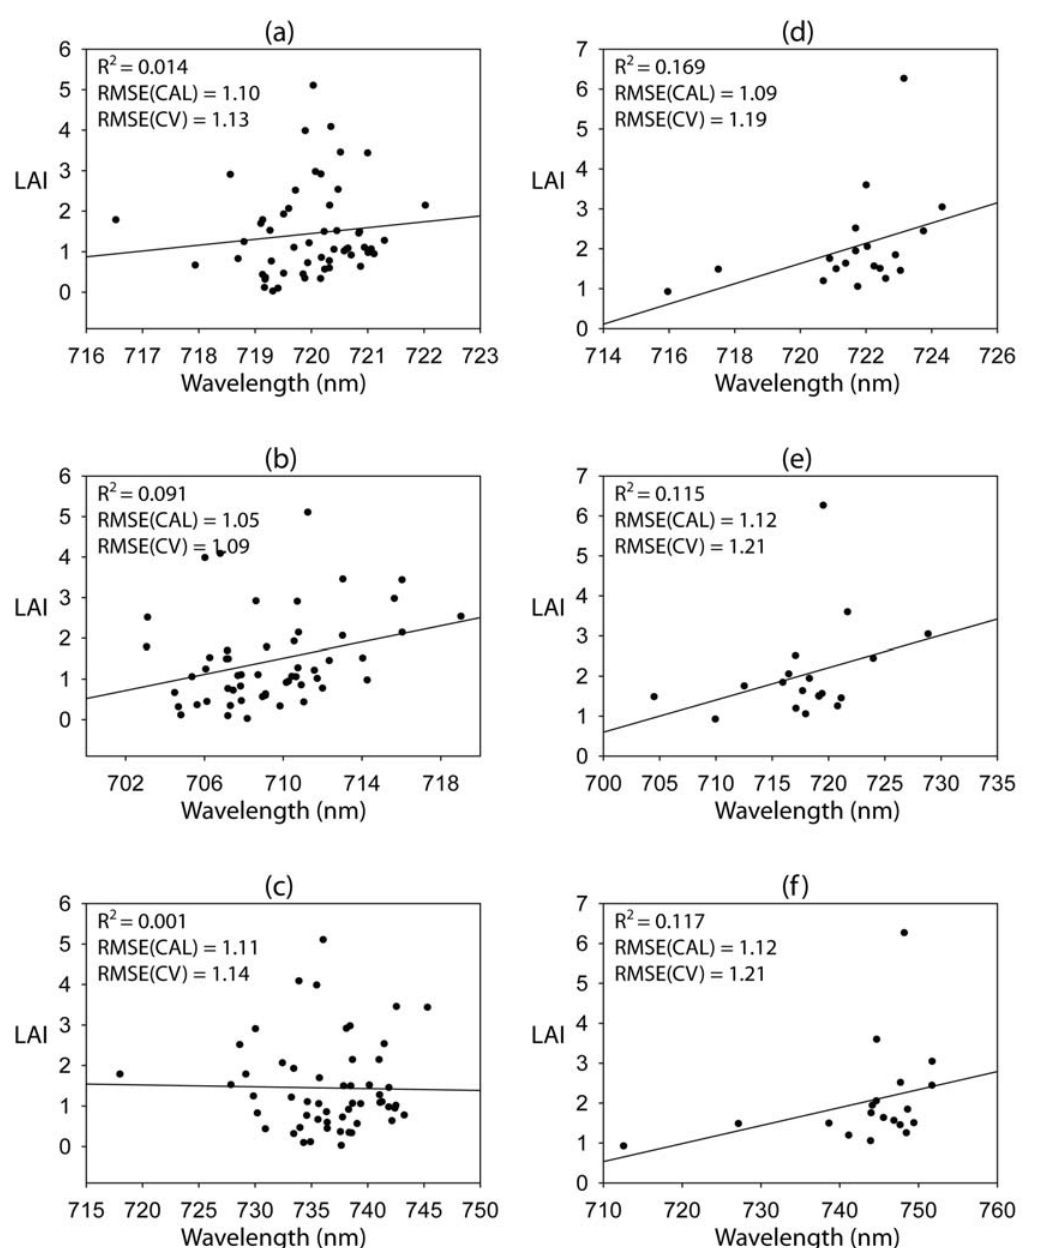
Figure 4. The scatterplots between each of the Red-edge position (REP) and LAI: using ( a ) LI_REP, ( b ) LG_REP, and ( c ) LE_REP for the Monticello, UT site; and using ( d ) LI_REP, ( e ) LG_REP, and ( f ) LE_REP for the Monument Valley, AZ Site. The R 2 and RMSEs from calibration (CAL) and cross-validation (CV) are also